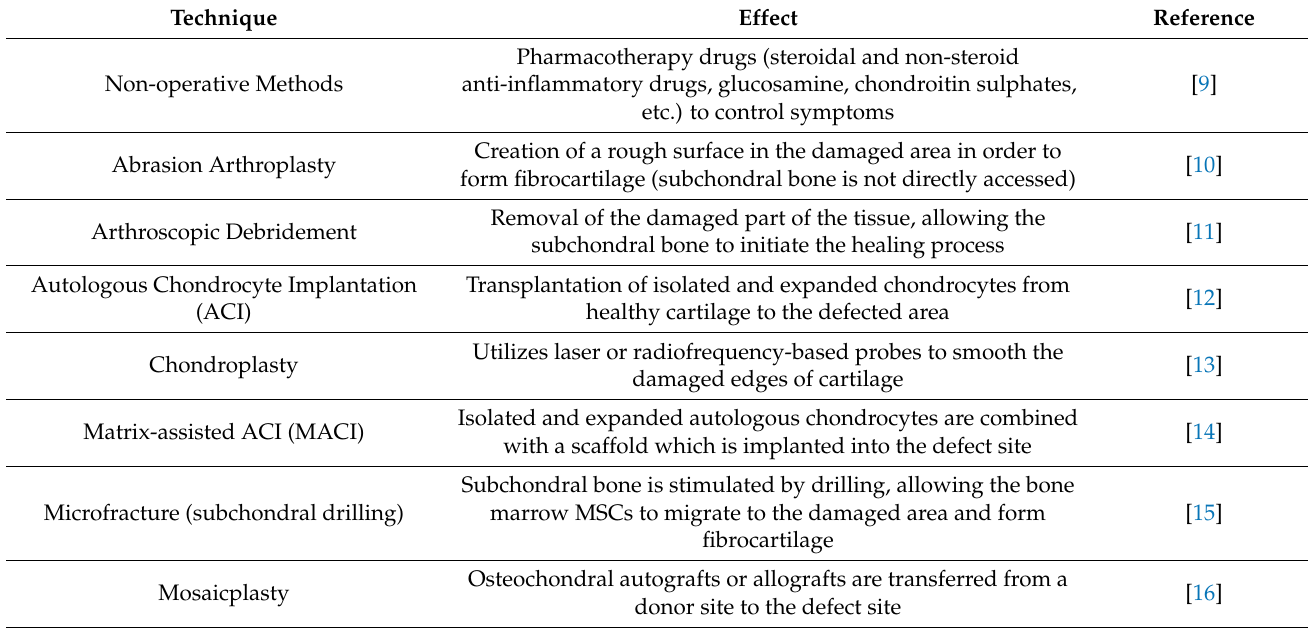
Table 1. Non-operative and operative treatment techniques for articular cartilage defects.